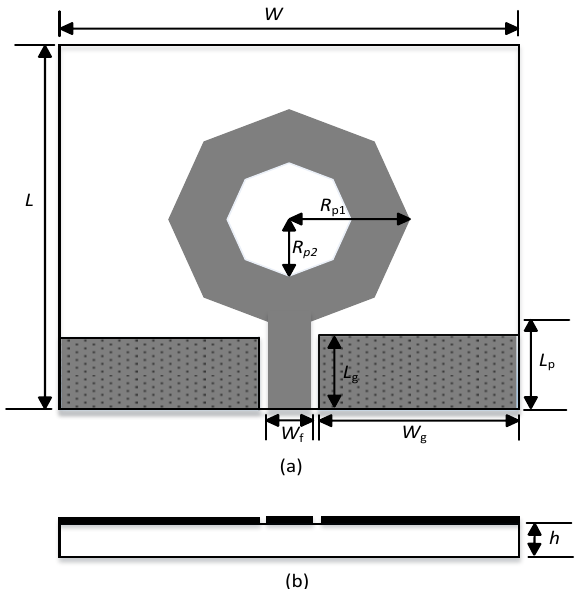
Figure 1: Schematic configuration of the proposed CPW- fed octagonal ring shape ultra wideband microstrip antenna.